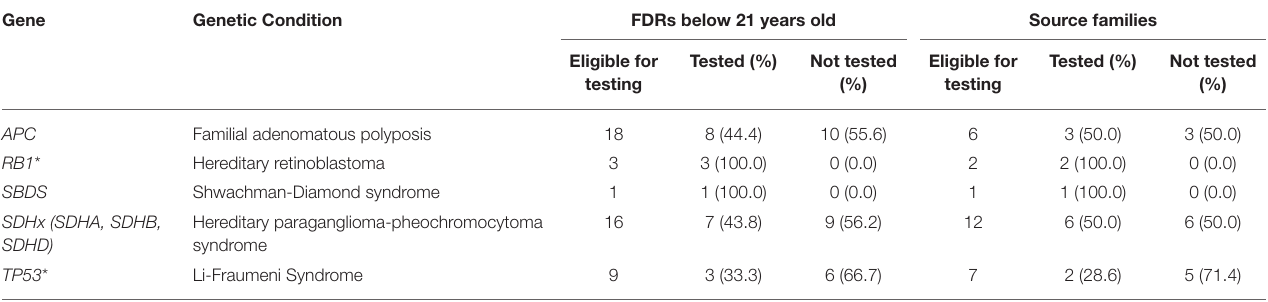
TABLE 3 | Proportion of FDRs who underwent predictive testing by gene. Gene Genetic Condition FDRs below 21 years old